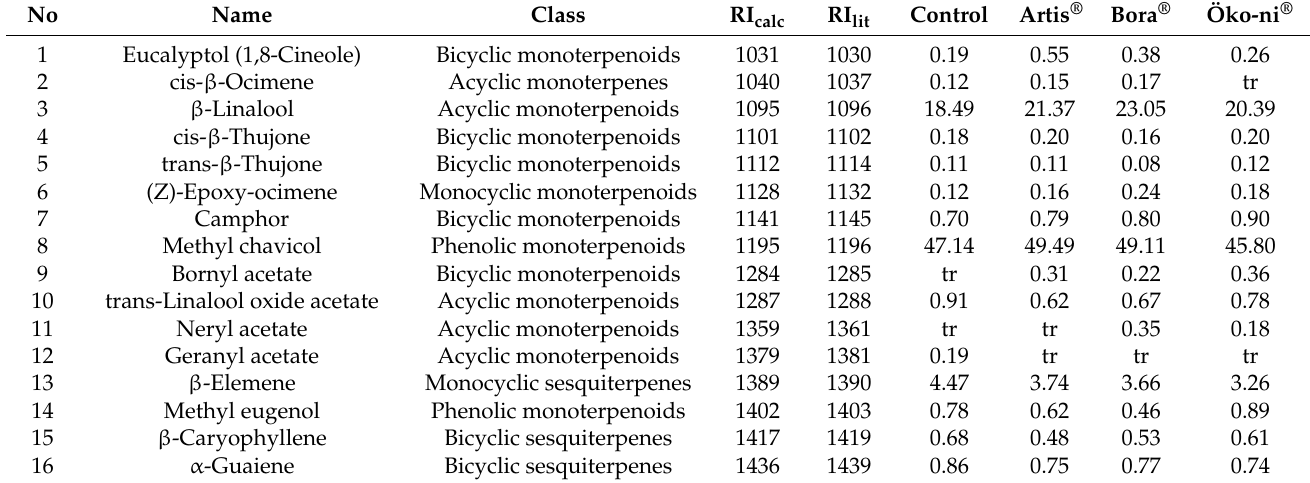
Table 4. Influence of myco-biocontrol formulates on essential oil composition of ‘Aromat de